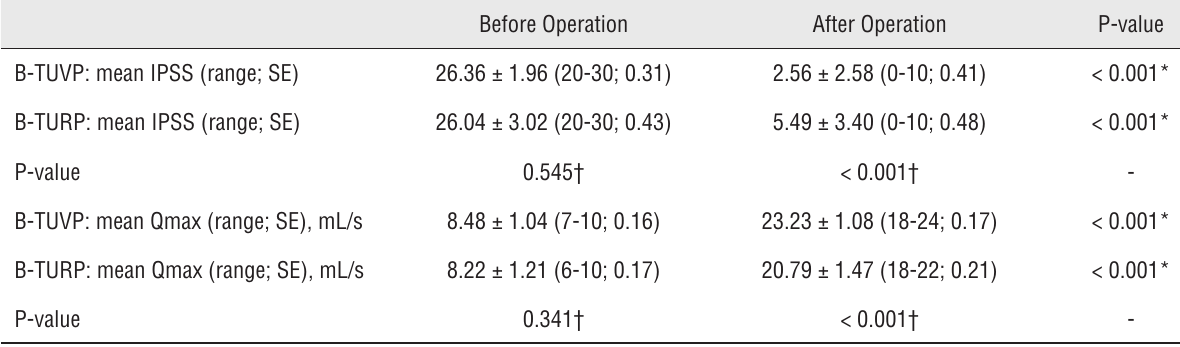
Table 2 - IPSS and Qmax in Bipolar TUVP (B-TUVP) and Bipolar TURP (B-TURP) groups. Before Operation After